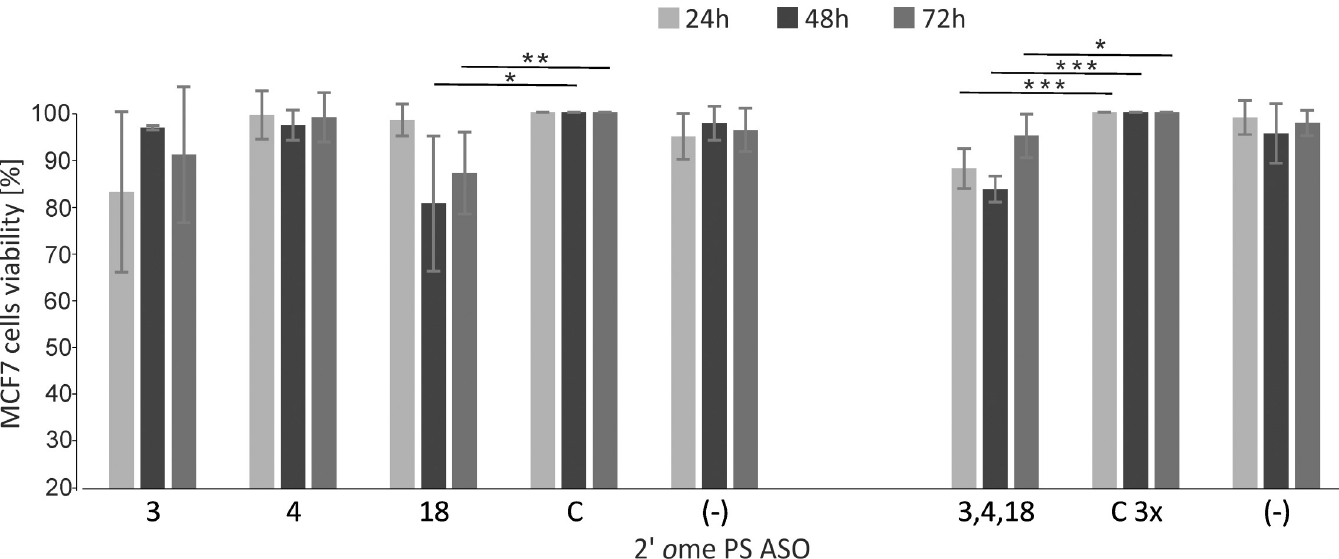
Fig 8. MCF7 cell lines viability assay upon transfection of 2 0 O Me PS RNA antisense oligonucleotides. Flow cytometry analysis of MCF7 viability by dual staining with Calcein/Ethidium Bromide. Cells were transfected with specified antisense oligomers and the mix of oligomers 3, 4 and 18. Control oligomer C was also used at a concentration of 3-fold higher than each of the other specific oligonucleotides: line C3x. The LIVE/DEAD assay was performed 24, 48 and 72 hours post transfection. Samples C(-) indicate no oligonucleotide added. The graph shows average values obtained from three independent experiments, normalized to oligomer C or C3x. The p value was calculated by the Student’s t-test and selected comparisons are marked with asterisks: ( p < 0.1) � , ( p < 0.05) �� , ( p < 0.01) ��� .